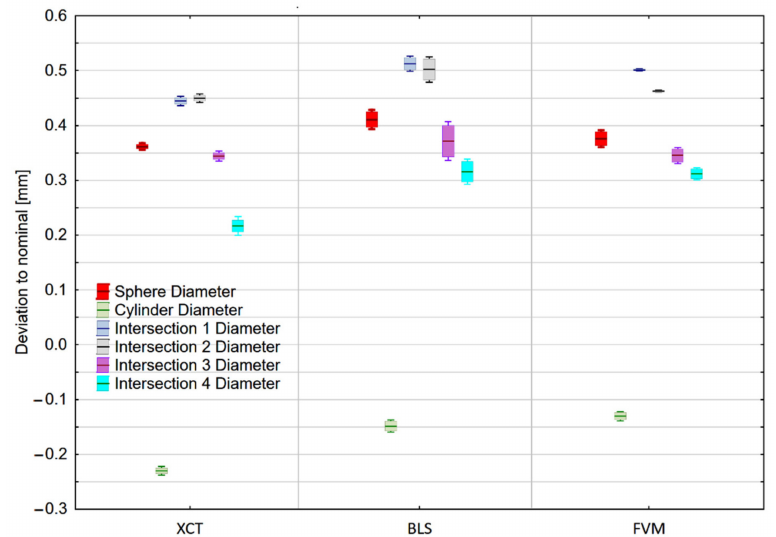
Figure 10. Measurement results of fitted geometric elements. Corresponding values of different elements are shifted for the purpose of data clarity. Box boundaries are equal to the standard deviation of the measurements, and whiskers represent the 95% confidence interval.